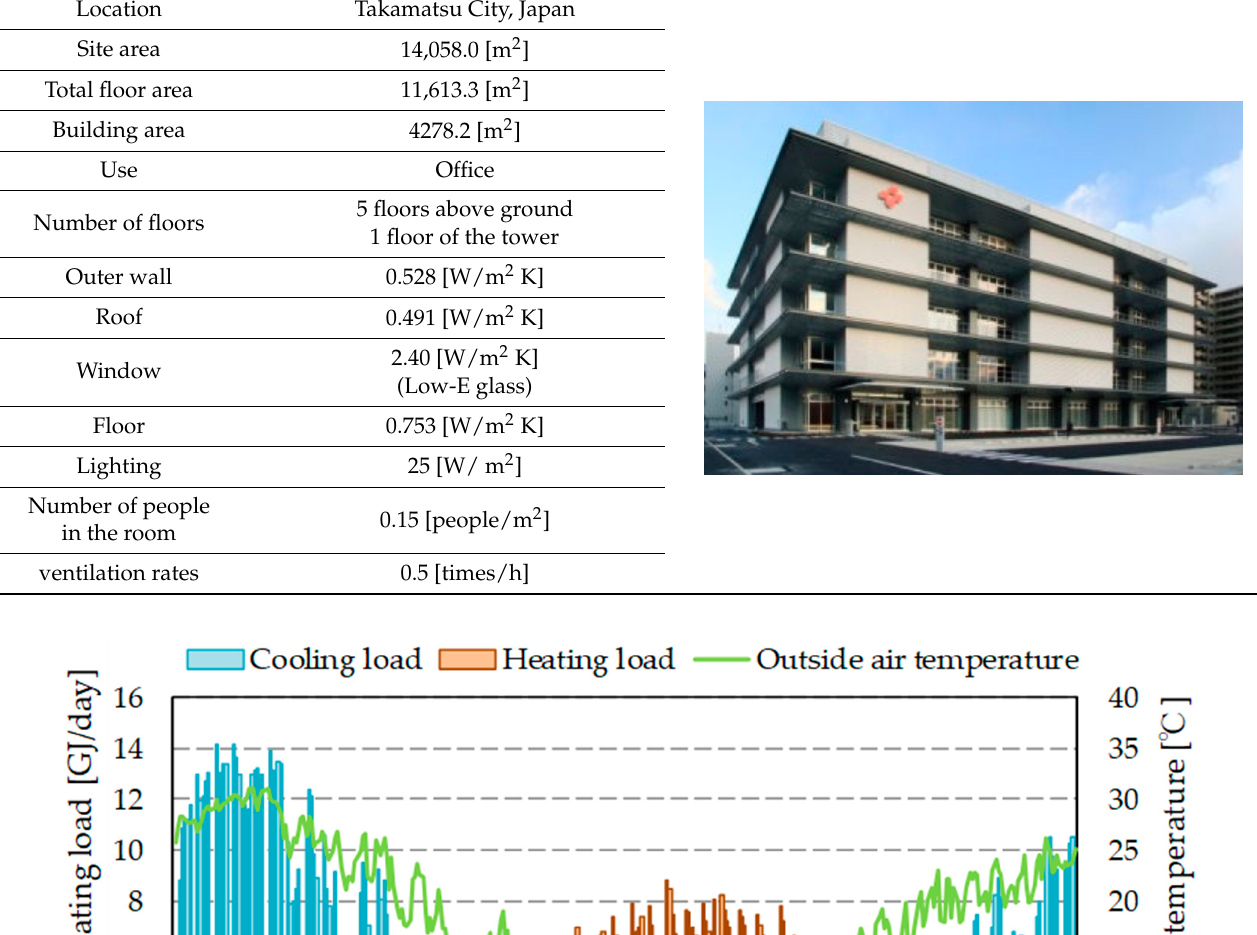
Figure 5. The cooling load and heating load and the outside air temperature of the building.